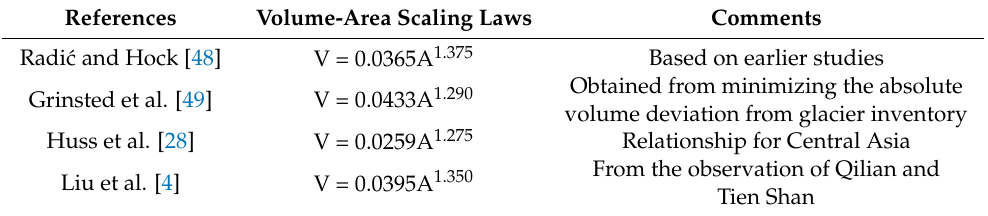
Table 3. The parameters of volume-area scaling law applied in recent